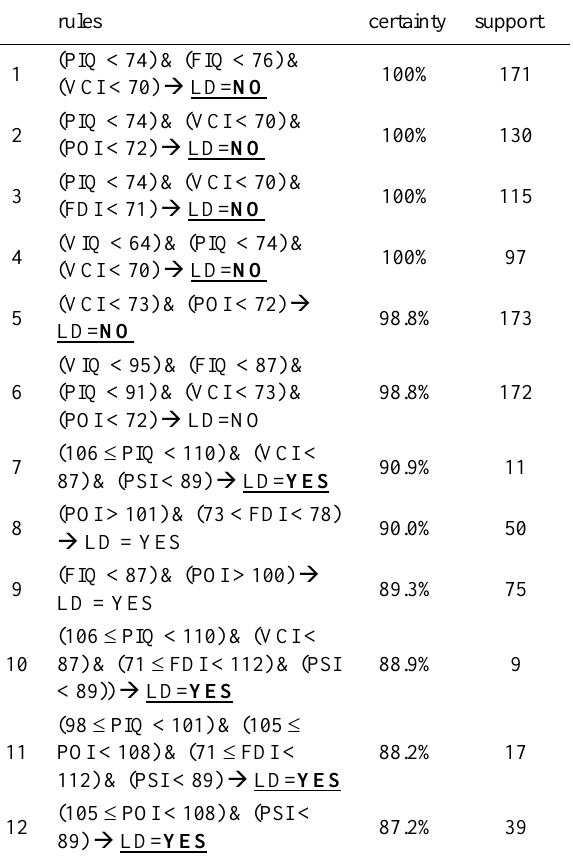
Table 12. Rules generated from data set A ∪ B with clustering prior to rules induction.